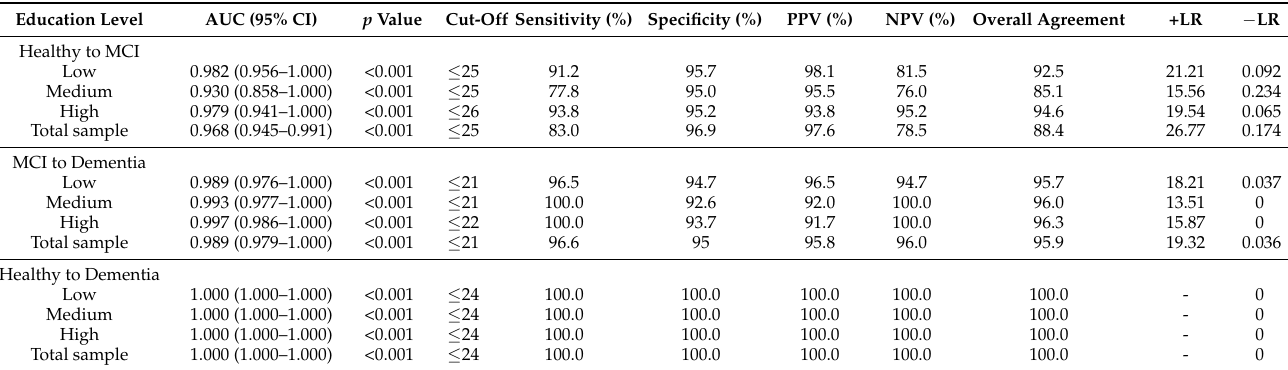
Table 6. Diagnostic ability of the